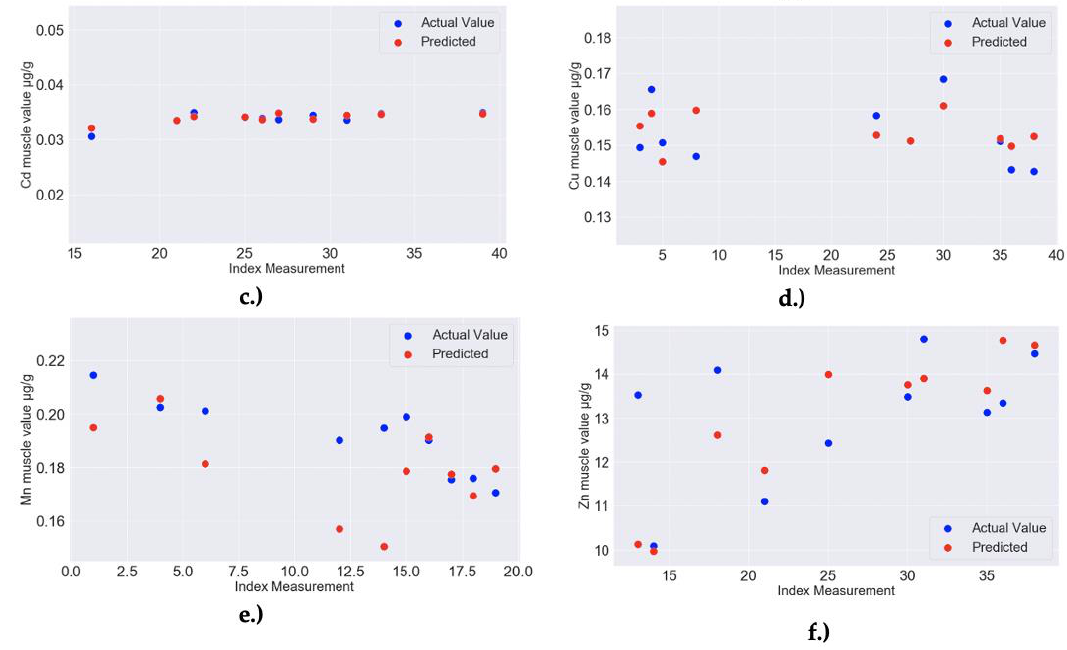
Figure A3. Prediction of heavy metals concentration for turbot muscle tissues—actual values vs. predicted value for first group non-linear tree-based RF prediction models, described in Section 2.2.2. (( a ). prediction for K concentration; ( b ). prediction for As concentration; ( c ). prediction for Cd concentration; ( d ). prediction for Cu concentration; ( e ). prediction for Mn concentration; ( f ). prediction for Zn concentration).